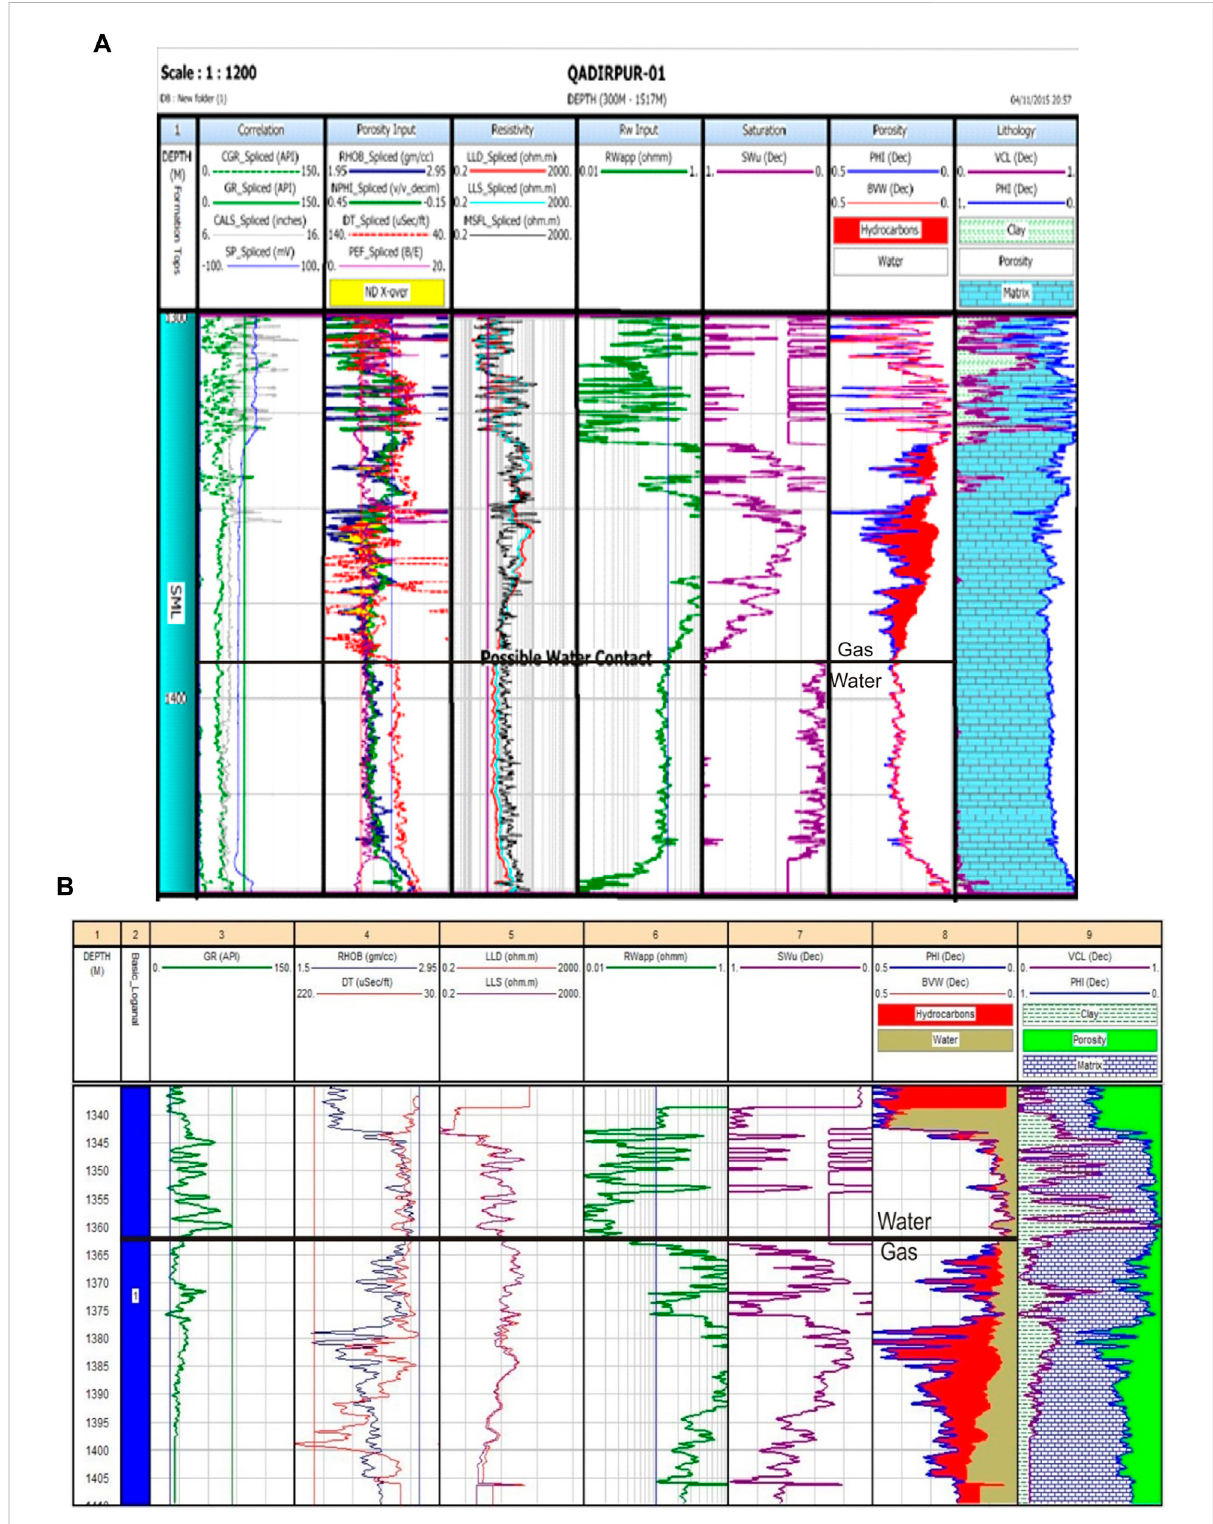
FIGURE 4 (A) Petrophysical analysis of the Sui Main Limestone encountered in well Q-01, (B) Petrophysical analysis of the Sui Main Limestone encountered in well Q-03, (C) Petrophysical analysis of the Sui Main Limestone encountered in well Q-05, (D) Petrophysical analysis of the Sui Main Limestone encountered in well-Q-12, (E) Petrophysical analysis of the Sui Main Limestone encountered in well